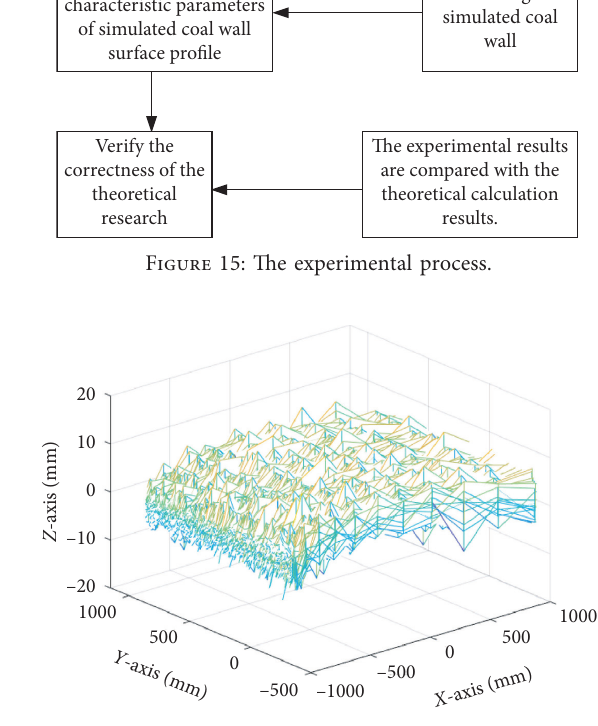
Figure 16: Comparison of experimental and theoretical